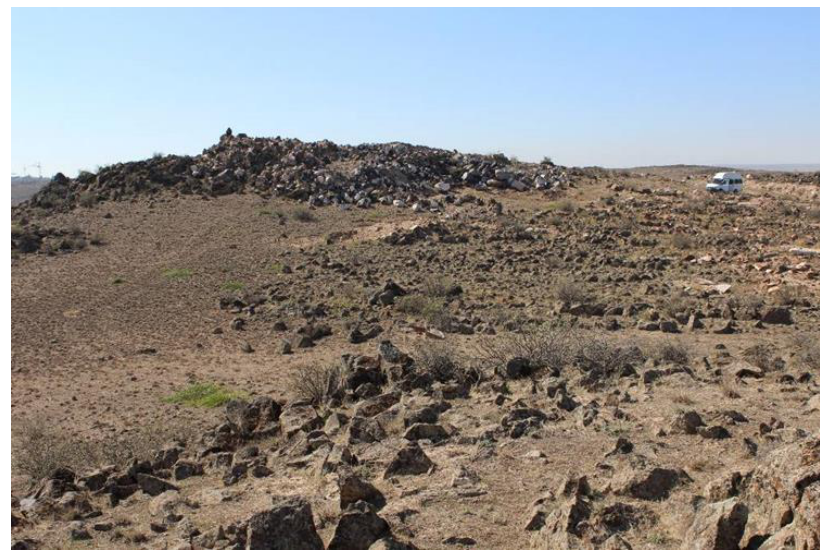
Figure 9. Armenia, Armavir province, Aygeshat site with traces of Iron Age cemetery.